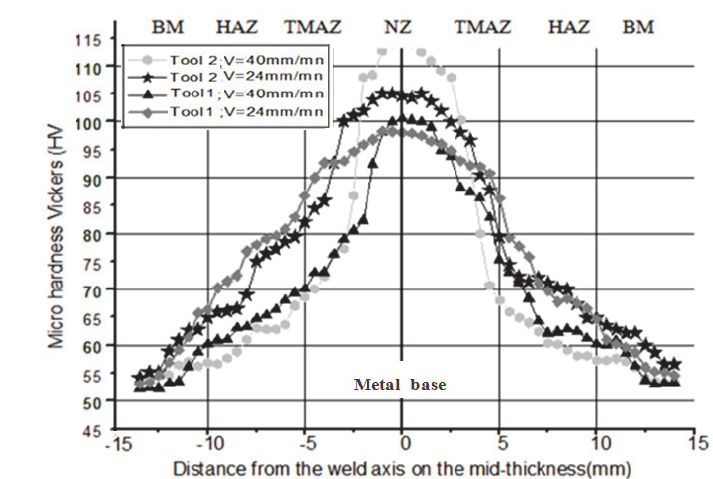
Fig. 9.: Variation of micro-hardness Vickers